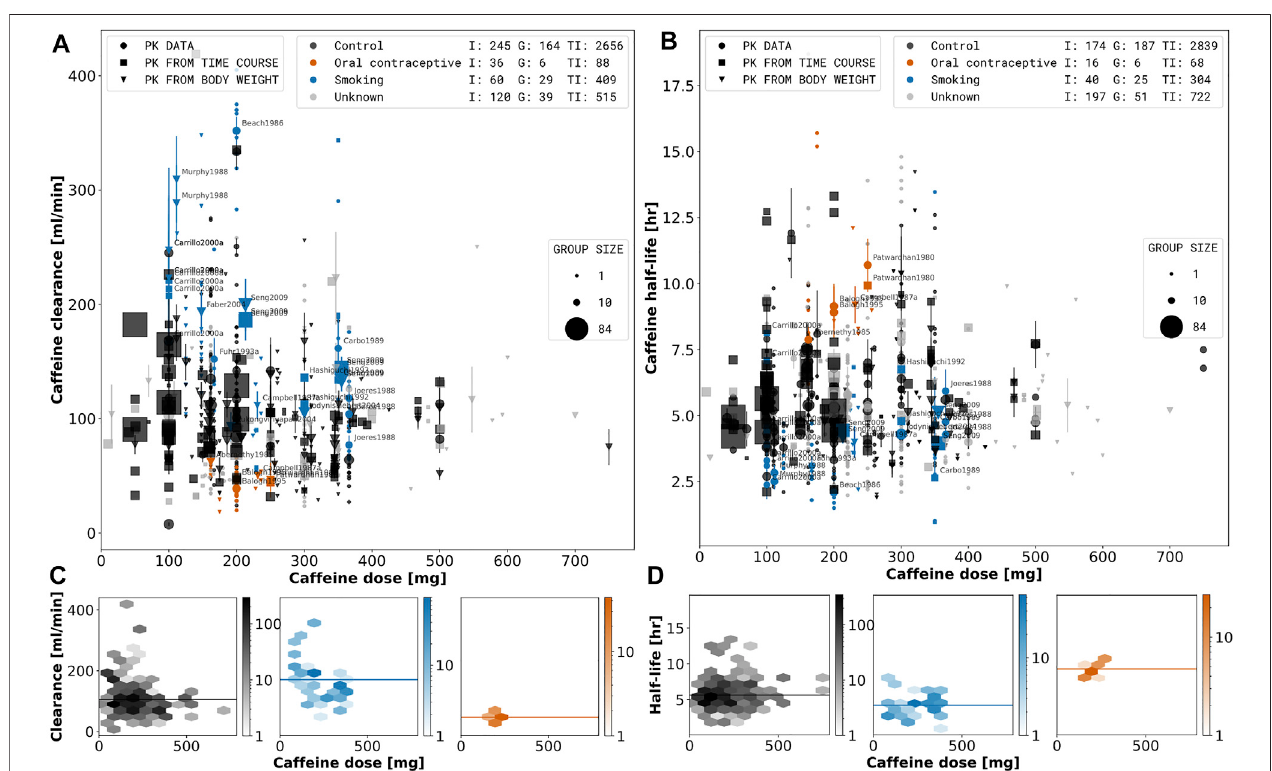
FIGURE 3 | Dose-dependent effect of smoking and oral contraceptive use on caffeine pharmacokinetics. A strati fi ed meta-analysis of caffeine clearance (A) and half-life (B) depending on reported smoking and oral contraceptive use and dose was performed. Black: Control subjects are non-smokers and not taking oral contraceptives; Orange: Oral contraceptive users independent of smoking status (smokers and non-smokers). Blue: Smoking are smokers not consuming oral contraceptives.Grey:Unknowndatacorrespondtosubjectswithunreportedsmokingandoralcontraceptivestatus.Markershape,andsizedescribethedatatype and group size, respectively. Data representing smokers or oral contraceptive consumers is labeled by the respective study name. The hexagonal bin plots in the lower panel (C,D) correspondtothesubsetofdataforthecontrol,smoking,andoralcontraceptiveconsumingsubjects.Thecolorintensityofeachbinrepresentsthenumber of subjects falling in a given hexagonal bin area. Data selection criteria and visualization are described in the Section 2 .